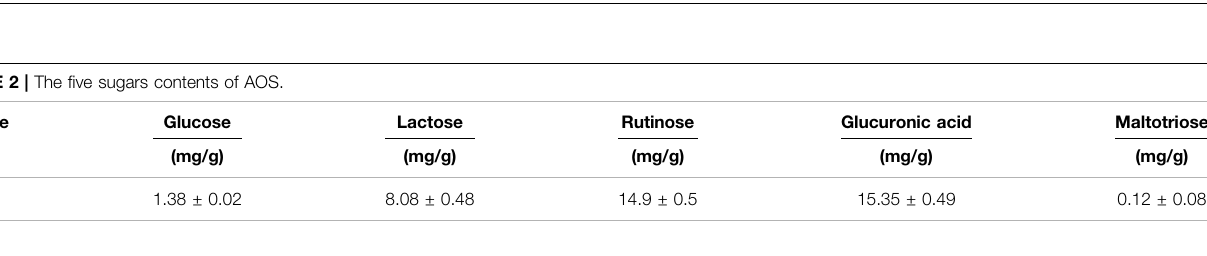
FIGURE9| ChromatogramofAOSderivativesof fi vekindsofmonosaccharide(A)andbasepeakchromatogramoftheAOSobtainedusinganMSEdatacollection method (UPLC-Q-TOF/MS E ) in positive mode. (B) Glucose, peak 375. (C) Lactose, peak 537. (D) Rutinose, peak 521. (E) Glucuronic acid, peak 389. (F) Maltotriose, peak 699.